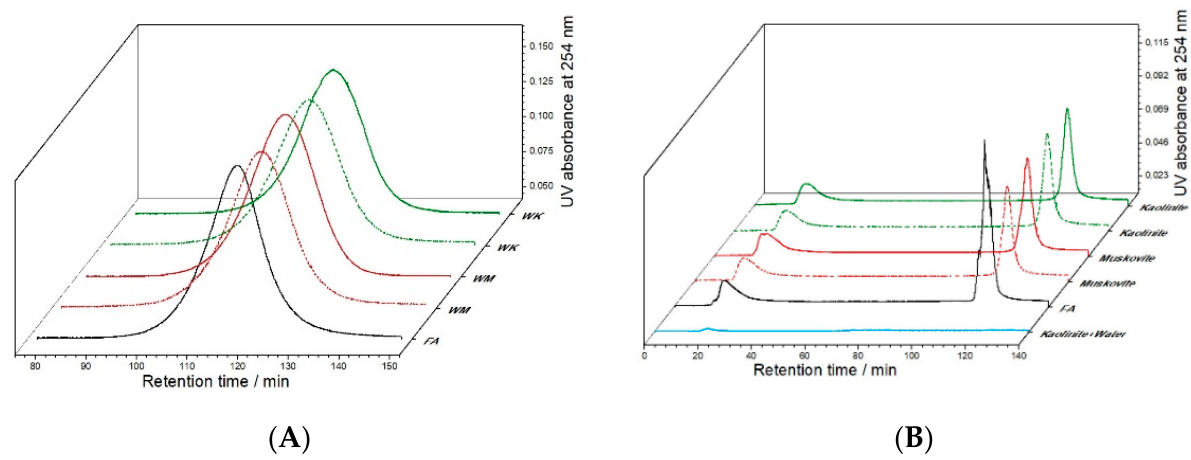
Figure 2. HPSEC chromatograms of FA ( A ) and amphiphilicity ( B ) before and after adsorption on kaolinite and muscovite. Table 2. The FA solution properties before and after adsorption on minerals and the amount of C org adsorbed. Sample